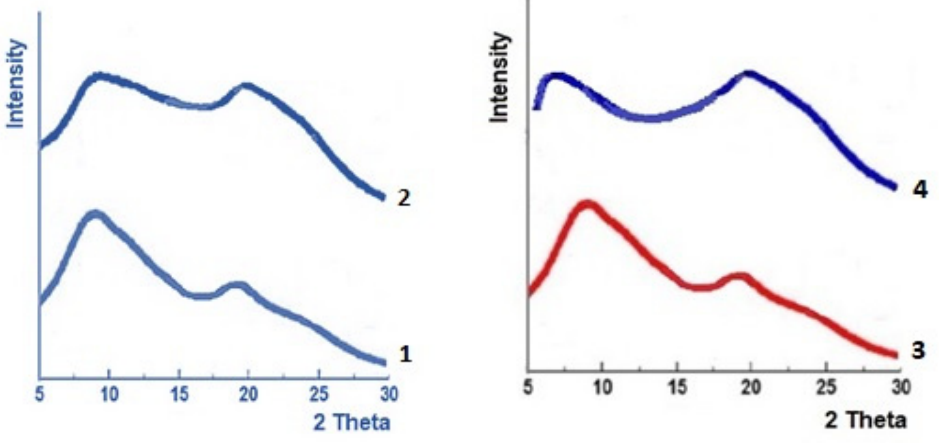
Figure 3. X-ray diffractograms of DAC ( 1 ), TAC ( 2 , 3 ) and TBC ( 4 ).